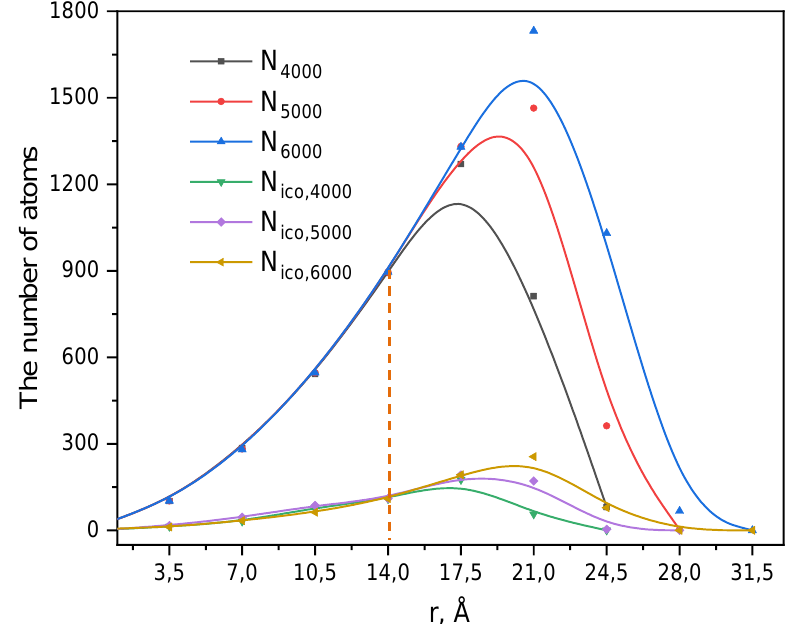
Figure 3. Distribution of atoms, ico-atoms for 4000, 5000, 6000 atoms sample through concentric spherical layers at 300 K